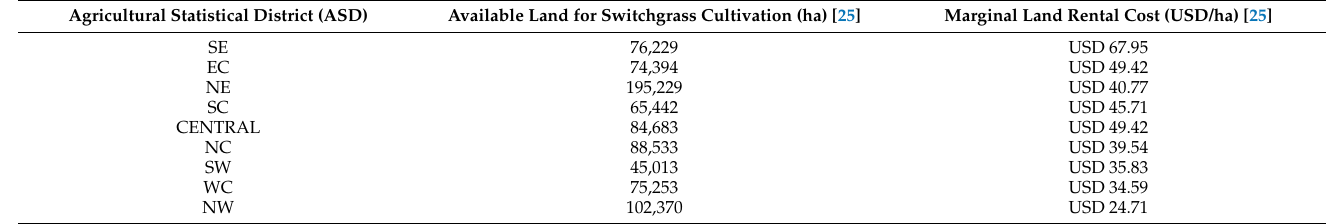
Figure 2. Switchgrass supply zones and North Dakota infrastructure for siting bioethanol plants. Table 1. Biomass feedstocks availability and marginal land rental cost.